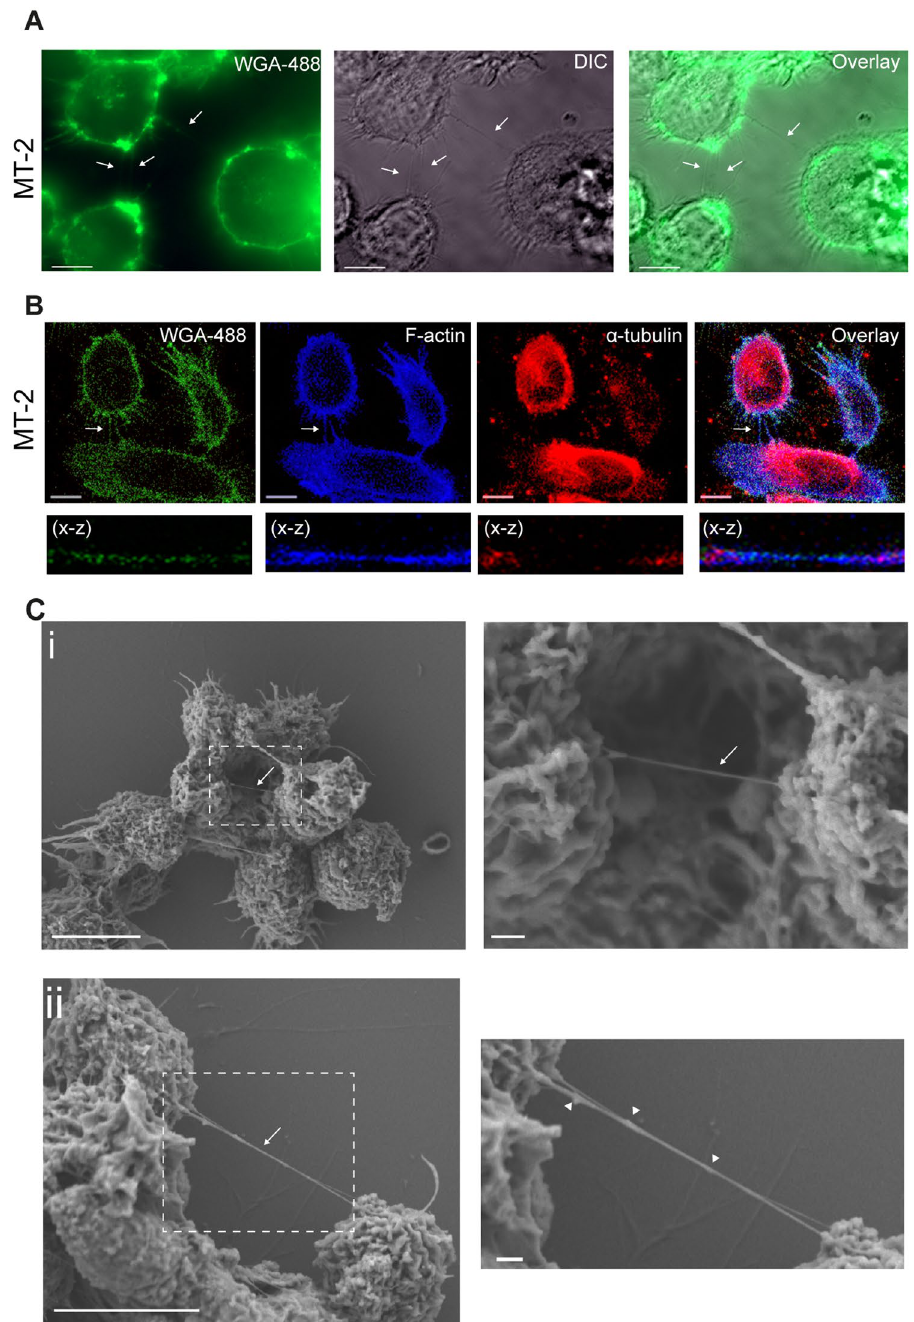
Figure 1. HTLV-1 expressing cells form tunneling nanotubes (TNTs). ( A ) MT-2 cells stained with WGA-488 (cellular membranes, green) and investigated by fluorescence microscopy. Arrows indicate thin membrane embedded intercellular connections. ( B ) MT-2 cells stained with WGA-488 (green), F-actin phalloidin-AF350 (blue) and an anti- α -tubulin antibody (red) and analyzed by confocal microscopy. Arrows indicate a TNT. The X-Z plane is obtained from a Z-stack (total 24 slices of 1 µ m each). ( C ) Scanning electron microscopy (SEM) of MT-2 cells connected by TNTs. Zoomed images to the right. Arrows indicate TNTs, arrowheads indicate bulges in TNTs. Images were captured by scanning electron microscope Jeol JSM-7400F LEI 4.0 kV, x3000 (x3700 for D2) and WD 8.0 mm. Confocal microscopy images were acquired by LSM780 confocal microscope (Zeiss) and fluorescence microscopy was acquired by AxioObserver Z1 (Zeiss). All images are representatives of three independent experiments, except for (C) that was performed once. All scale bars 10 µ m except zoomed SEM images; 1 µ m. Adobe photoshop CS6 was used to prepare the images. The contrast was enhanced on the whole image to better represent and visualize the thin TNT